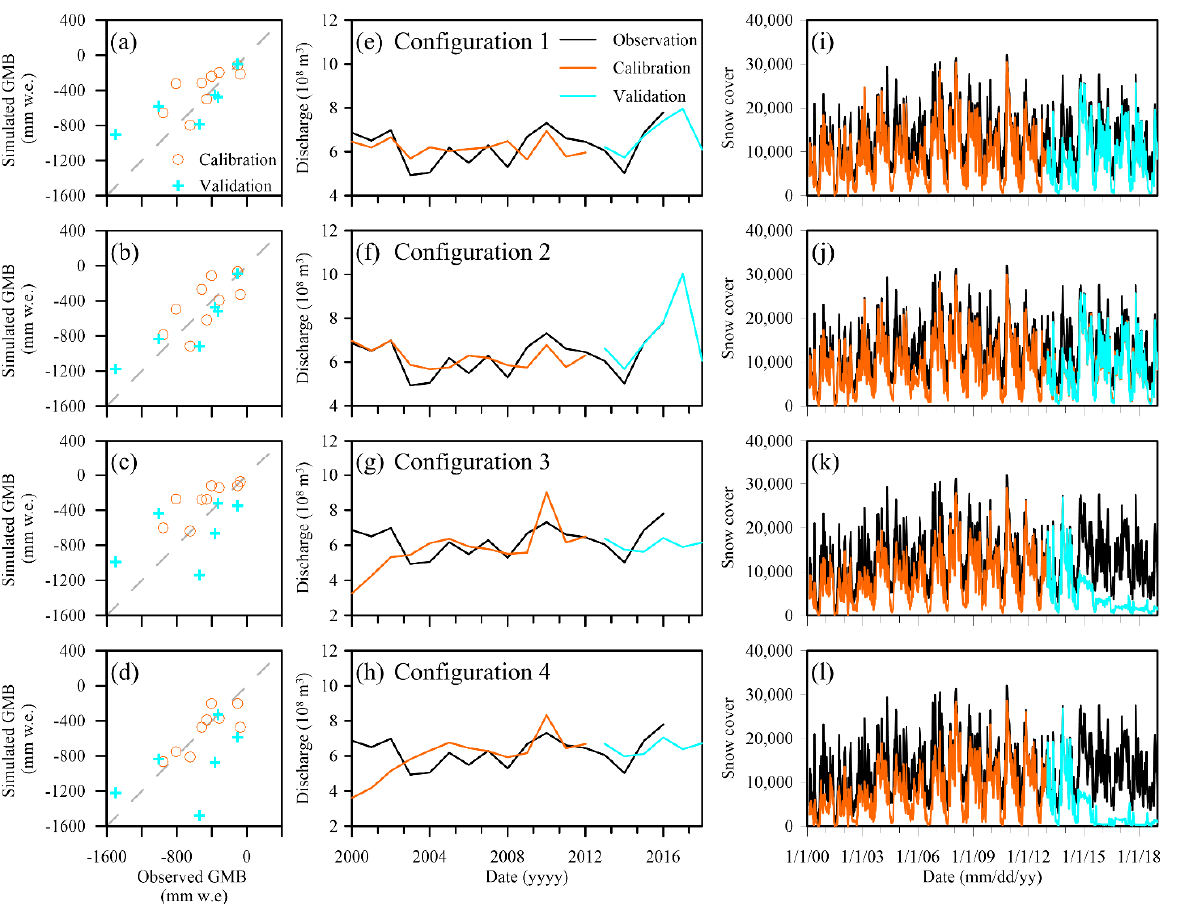
Figure 3. Simulated glacier mass balance ( a – d ), runoff ( e – h ) and snow cover ( i – l ) using the four con fi gurations in the Toule basins compared with observations, where the model results in the four rows correspond to Con fi gurations 1–4, respectively.